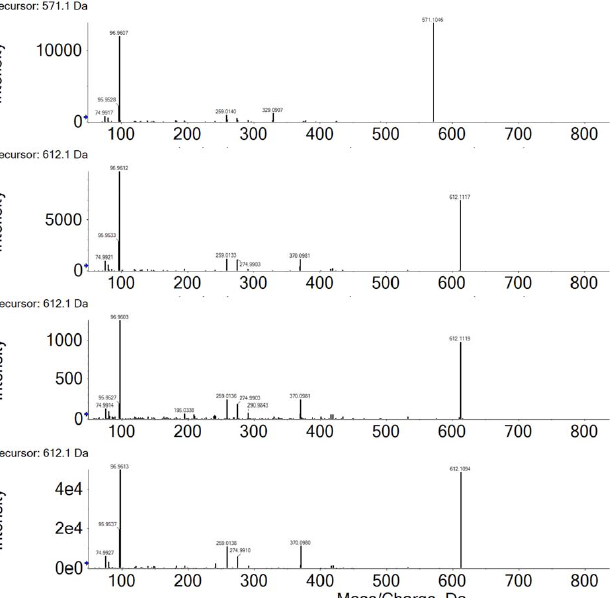
Figure S2: MS/MS spectra for glucosinolates found in M. oleifera . Mass fragments at -10 eV for the precursor ions 571.1 (4-α-L-rhamnopyranosyloxy-benzyl glucosinolates) and 612 (acetyl-4- α -L-rhamnopyranosyloxy-benzyl glucosinolates isomers 1-3).